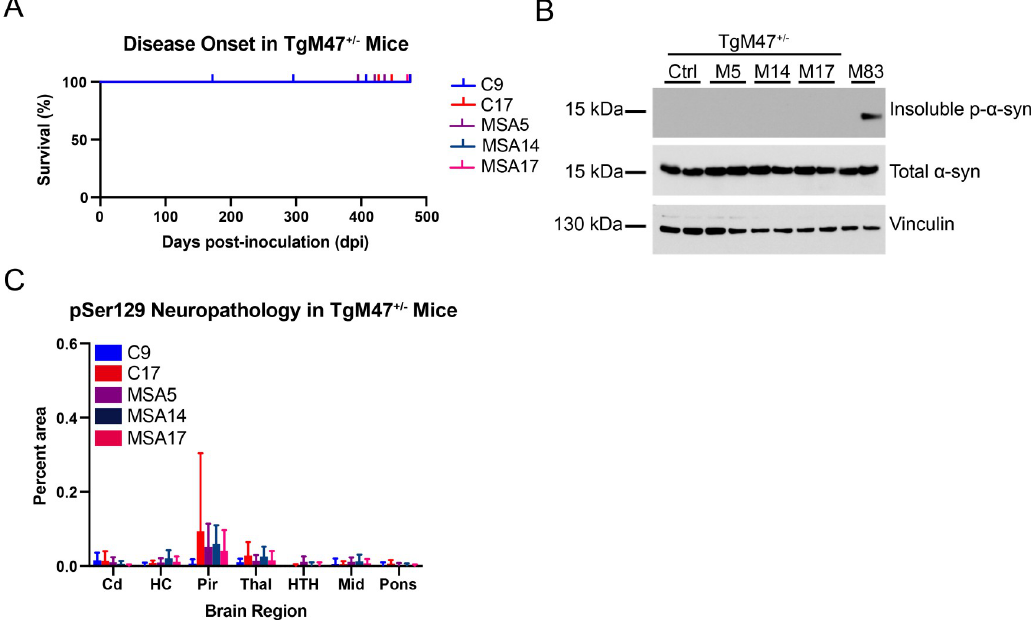
Fig 1. TgM47 +/- mice are resistant to MSA prion transmission. Eight-week old TgM47 +/- mice were inoculated with either control (C9 and C17) or MSA patient samples (MSA5, MSA14, and MSA17). (A) Kaplan-Meier plot of disease onset in TgM47 +/- mice following inoculation. TgM47 +/- mice did not develop overt motor signs by 475 days postinoculation (dpi; P > 0.05). (B) Two brain homogenates from TgM47 +/- mice inoculated with either control or with each of the MSA patient samples were assayed for the presence of insoluble α -synuclein following detergent extraction. An MSA-inoculated TgM83 +/- mouse brain, which we have previously shown is positive for phosphorylated α -synuclein, was included as a positive control (EP1536Y primary antibody). None of the homogenates from the inoculated mice contained aggregated α -synuclein, though total α -synuclein levels (MJFR1 primary antibody) were consistent across all homogenates tested. Vinculin shown as a loading control. (C) Fixed half- brains from the same mice were analyzed for phosphorylated α -synuclein neuropathology in the caudate (Cd), hippocampus (HC), piriform cortex and amygdala (Pir), thalamus (Thal), hypothalamus (HTH), midbrain (Mid), and pons. None of the inoculated animals developed detectable pathology ( P >